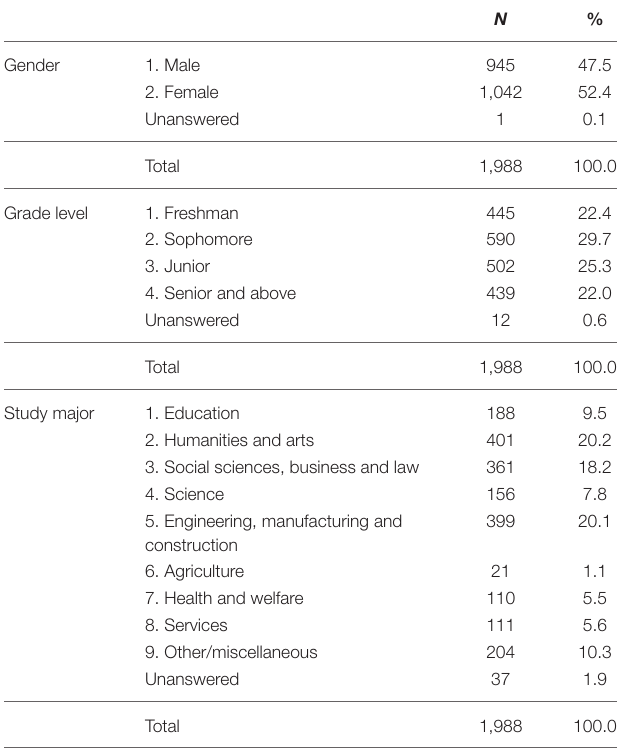
TABLE 3 | Demographic profiles of the